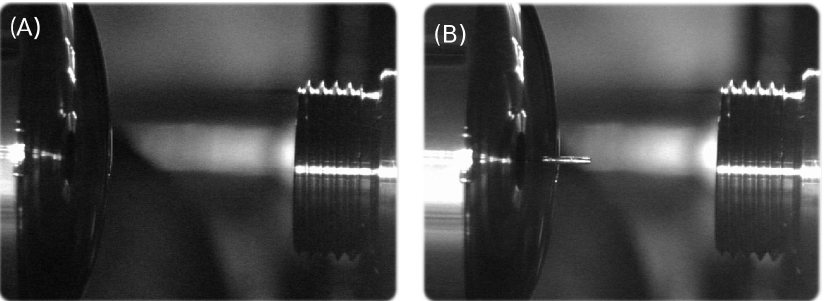
FIG. 14. Nb 3 Sn wire installation inside the 500 kV pulsed gun. Wire flushed with the cathode surface (a) and 6 mm above the cathode surface (b). In this configuration the anode has not been mounted to facilitate charge transport towards the rf cavity. Only its M20 thread is visible.